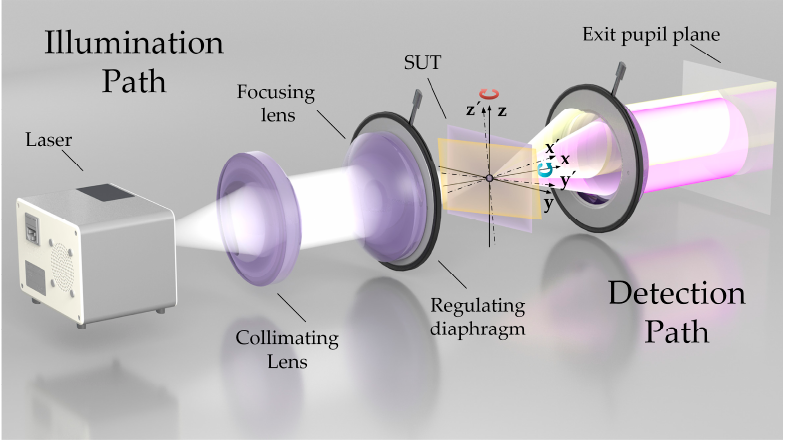
Figure 1. Optical setup of a typical unfolded confocal